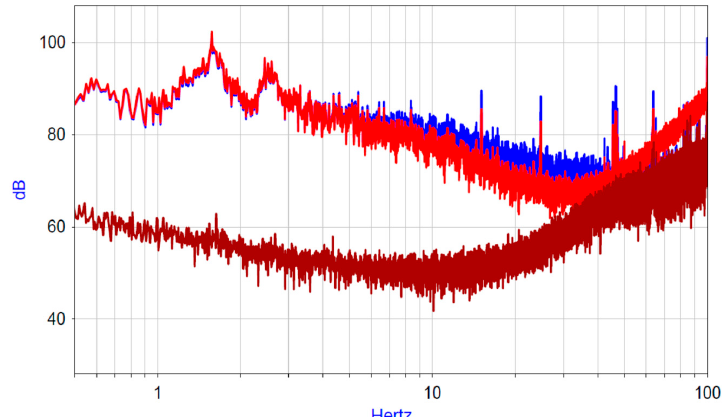
Figure 5. Power spectral density of the hydrophone signals. Blue and light-red lines are the spectra of the hydrophone signals. Red line is the noise spectral density.